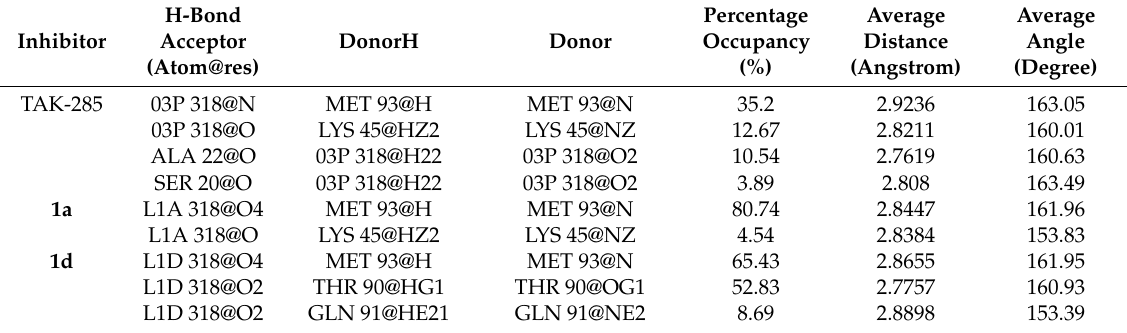
Table 2. Hydrogen Bonds Analysis with MD Simulation for the EGFR Inhibitors within the ATP Active